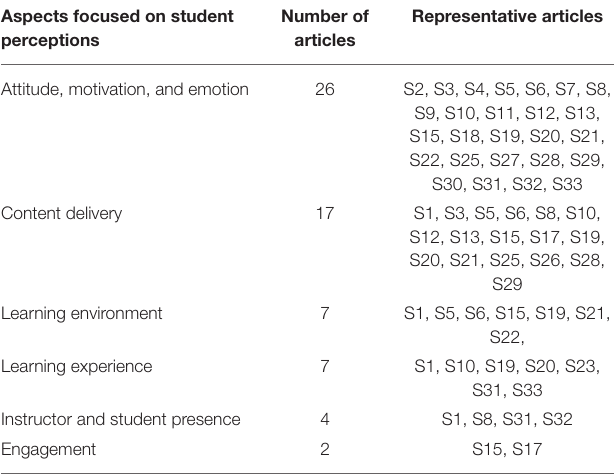
TABLE 5 | Different research foci on student perceptions and their representative